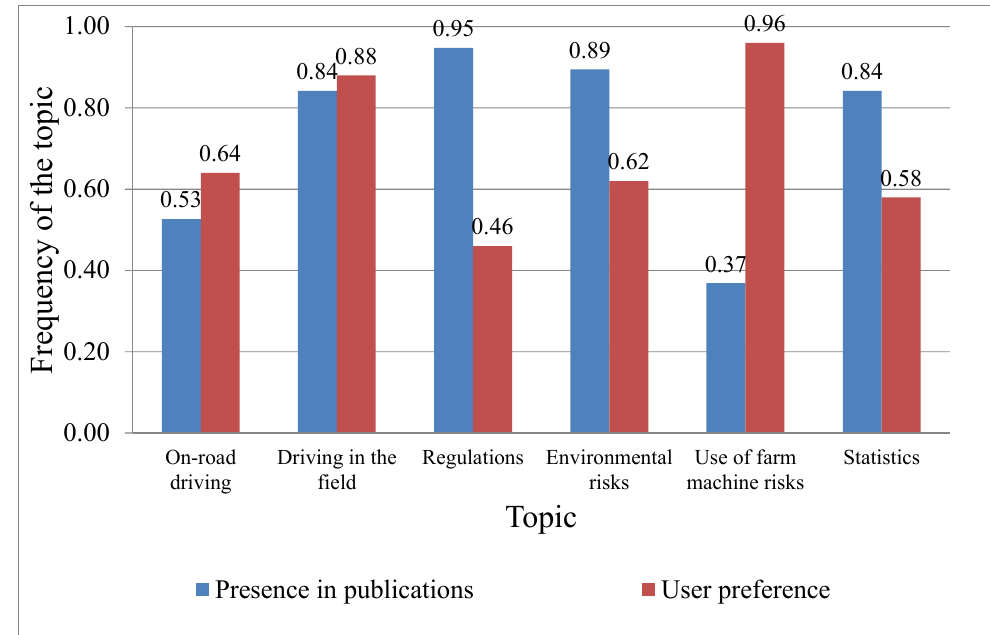
Figure 2. Frequencies of the topics dealt with in the sample of the 19 analysed publications (blue) and the normalized average scores expressed by the 19 operators (red) in the Information category.